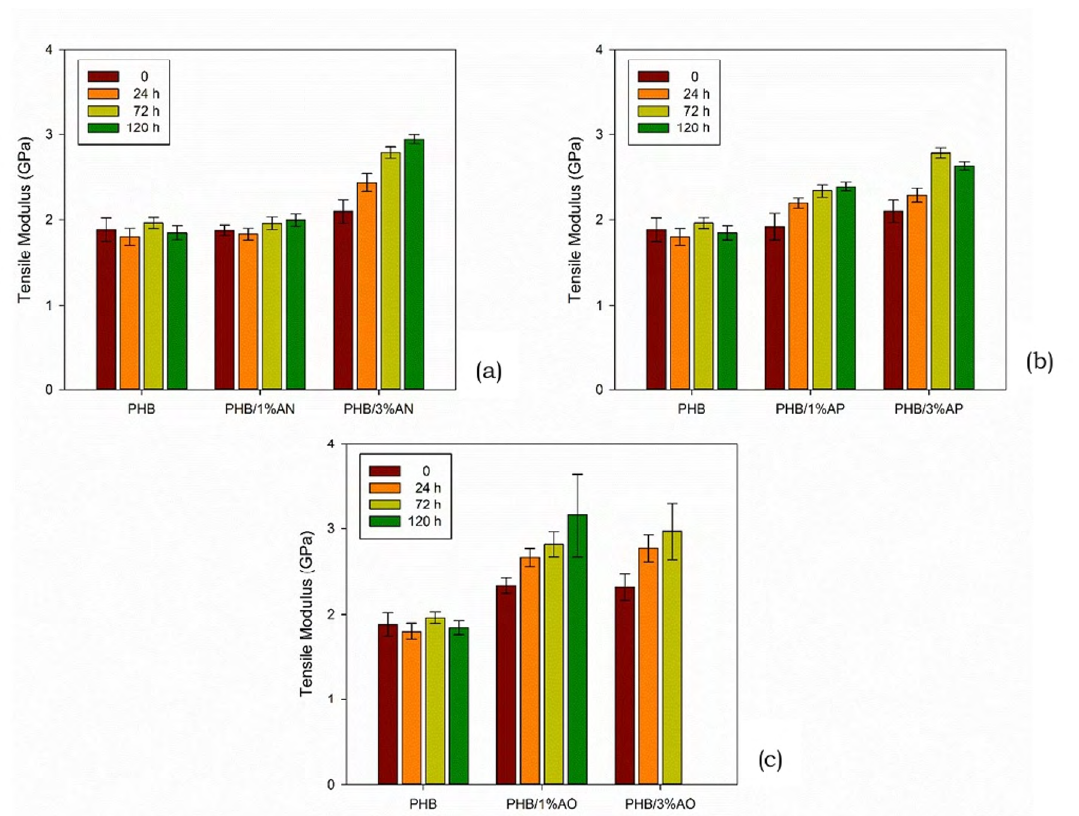
Figure 6. Effect of thermal aging at 115ºC for indicated times on the tensile modulus of PHB and PHB compounds with natural (a), purified (b) and, purified/organophilized Bentonite (c).